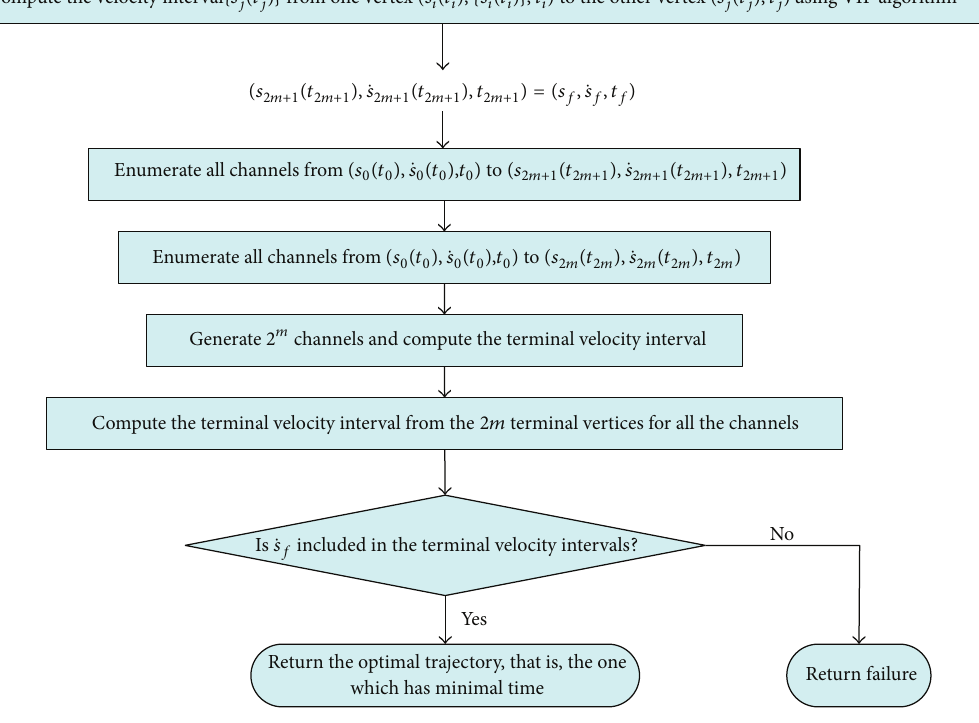
Figure 2: Flowchart of optimal trajectory